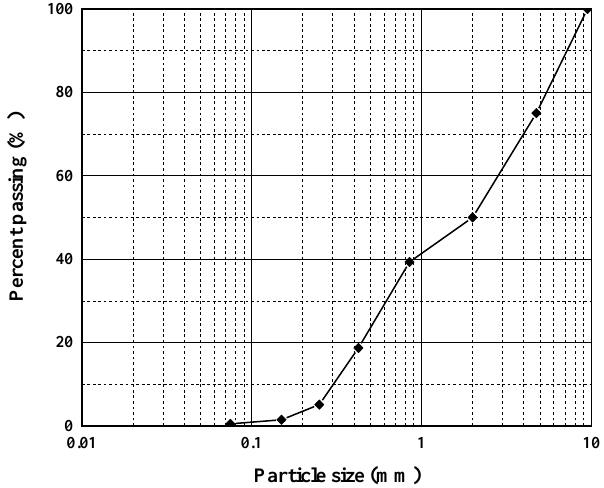
Figure 3. Particle size distribution curve of the mixed sediment used in the laboratory tests. Table 2. Weights of mixed samples for laboratory tests.